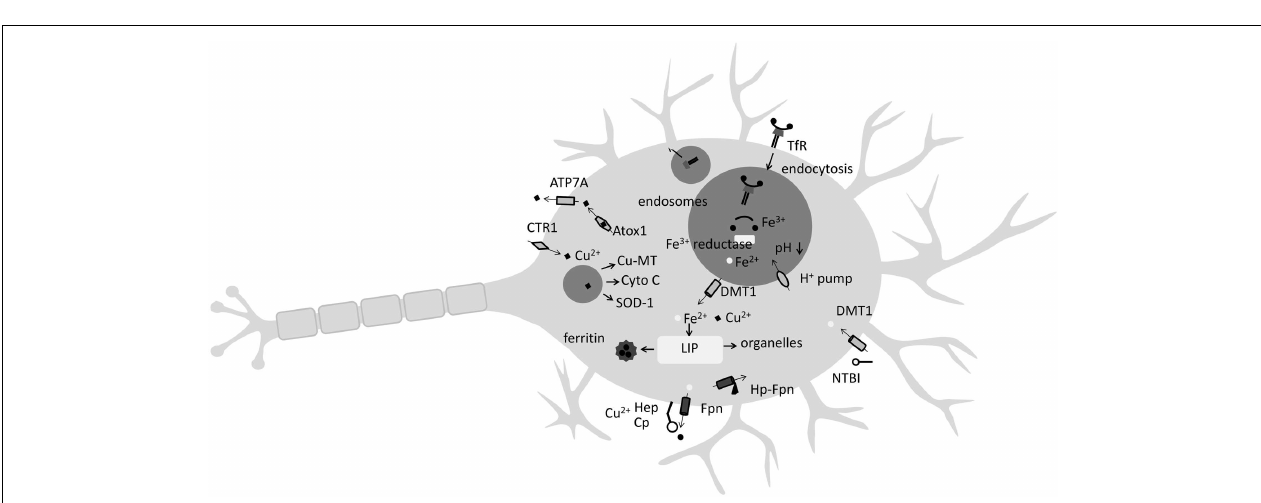
directed to organelles such as lysosomes. Copper (Cu) uptake occurs at neuron surface by copper transporter-1 (CTR1). Following endocytosis, Cu 2 + ions are incorporated into Cu-metallothionein (Cu-MT), cytochrome c , or superoxide dismutase 1 (SOD-1). Ferroportin (Fpn), the only known Fe exporter from neurons, relies on the Cu-containing metalloenzymes hephaestin (Hep) or ceruloplasmin (Cp) for activity. Hepcidin (Hp) activity can internalize